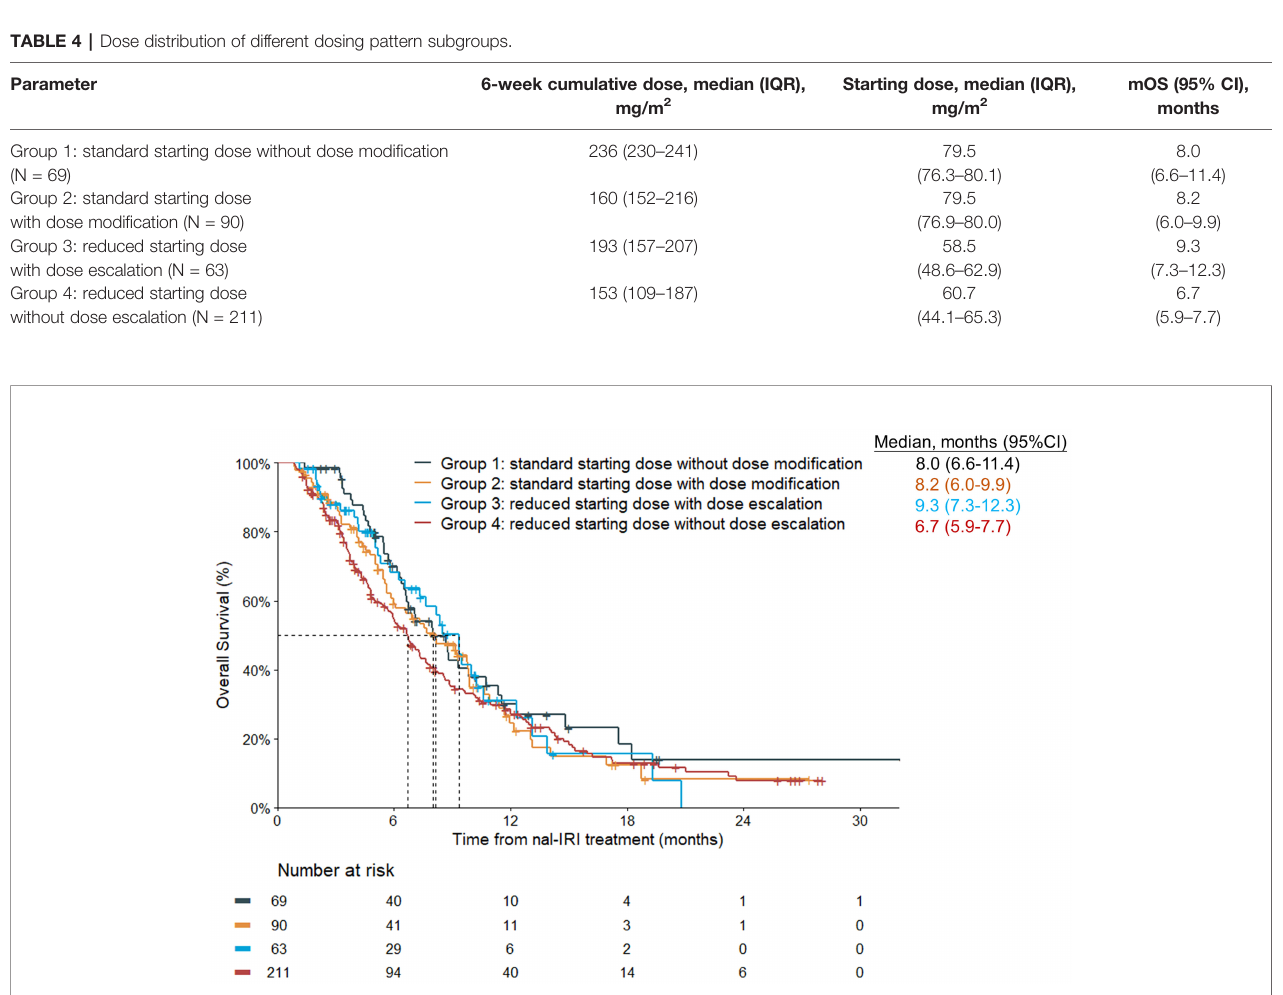
FIGURE 4 | The Kaplan – Meier plot of OS in the different dosing pattern groups. Only included patients received at least two doses of nal-IRI+5FU/LV.